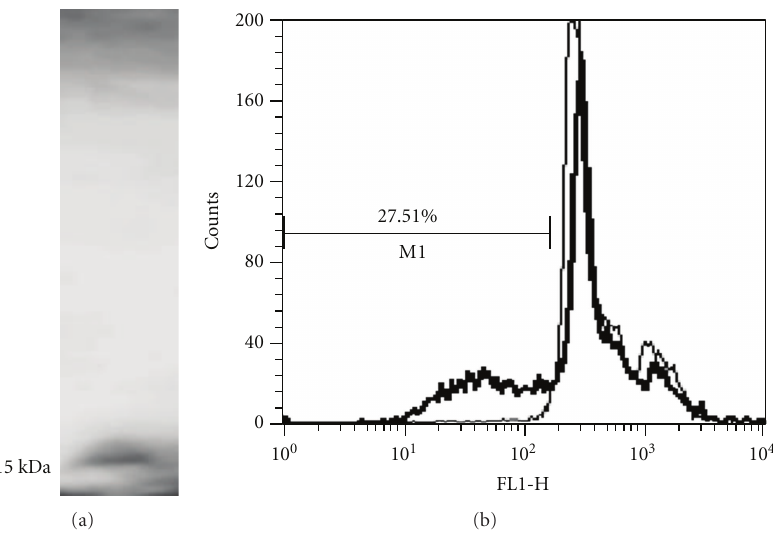
Figure 5: Engagement of mitochondrial factors in the caspase-dependent phase of the death cascade triggered by LpqH. (a) To know if LpqH induces transfer of cytochrome c from the mitochondria to the cytosol, we perform immunoblot of cytosolic fractions with an antibody to human cytochrome c after 24h LpqH apoptosis. (b) To determine the mitochondrial membrane damage, we analyzed the mitochondrial membrane potential ( ΔΨ m) by flow cytometry with DiOC6 in cells induced to apoptosis for 24 h; 27.51% loss in DiOC6 staining is